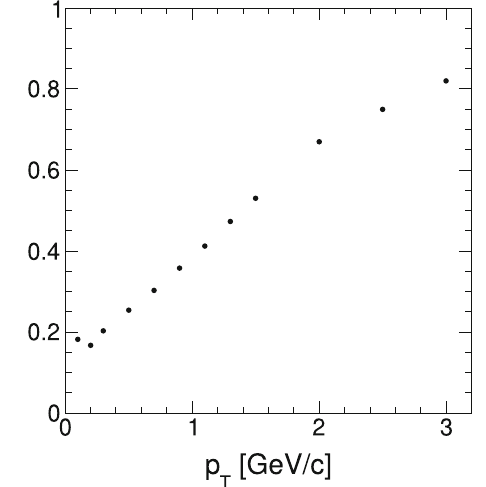
Fig. 87 Exponential slope of the log ( s ) dependence of the RHIC and LHC data as a function of p